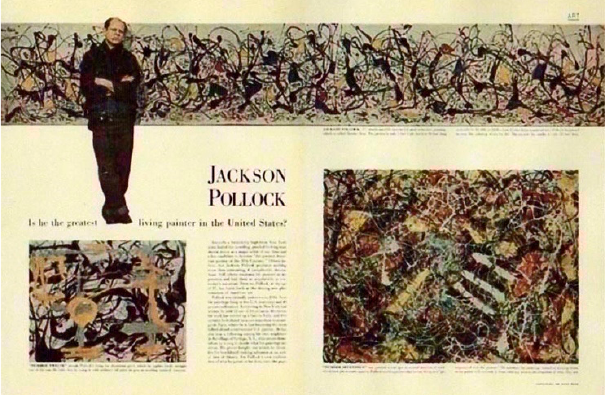
Figure 21. Pollock in front of his painting Summertime 1948, photograph for the article “Jackson Pollock”, LIFE, 8/8/49 ©1949. Used with permission. Photograph by © Arnold Newman Properties/Getty Images.